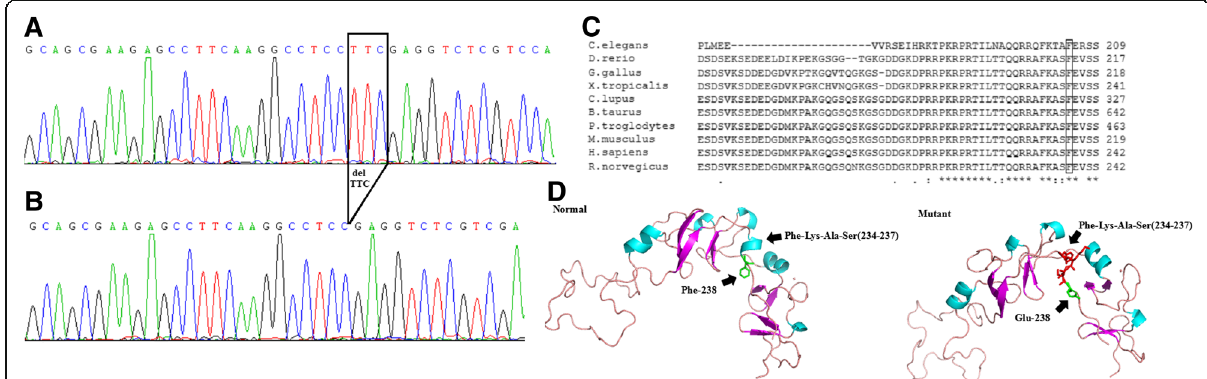
Fig. 2 Sanger sequence and amino acid alignment of c.712_714delTTC of the LMX1B gene and prediction of the protein conformational changes by SWISS-MODEL. a Wild type allele DNA sequence of exon 4 of LMX1B (GenBank Accession: NM_002316.3) derived from subclone results of patient V-5. b The equivalent region from subclone results of patient V-5 showing the novel deletion mutation c.712_714delTTC. c Amino acid alignments show that c.712_714delTTC mutation occurs at a highly conserved position in LMX1B , as shown by comparing the corresponding sequence of 10 species. d Prediction of 3D structure changes in mutant LMX1B protein. The helical structure of Phe234-Lys235-Ala236-Ser237 was abolished and transformed into